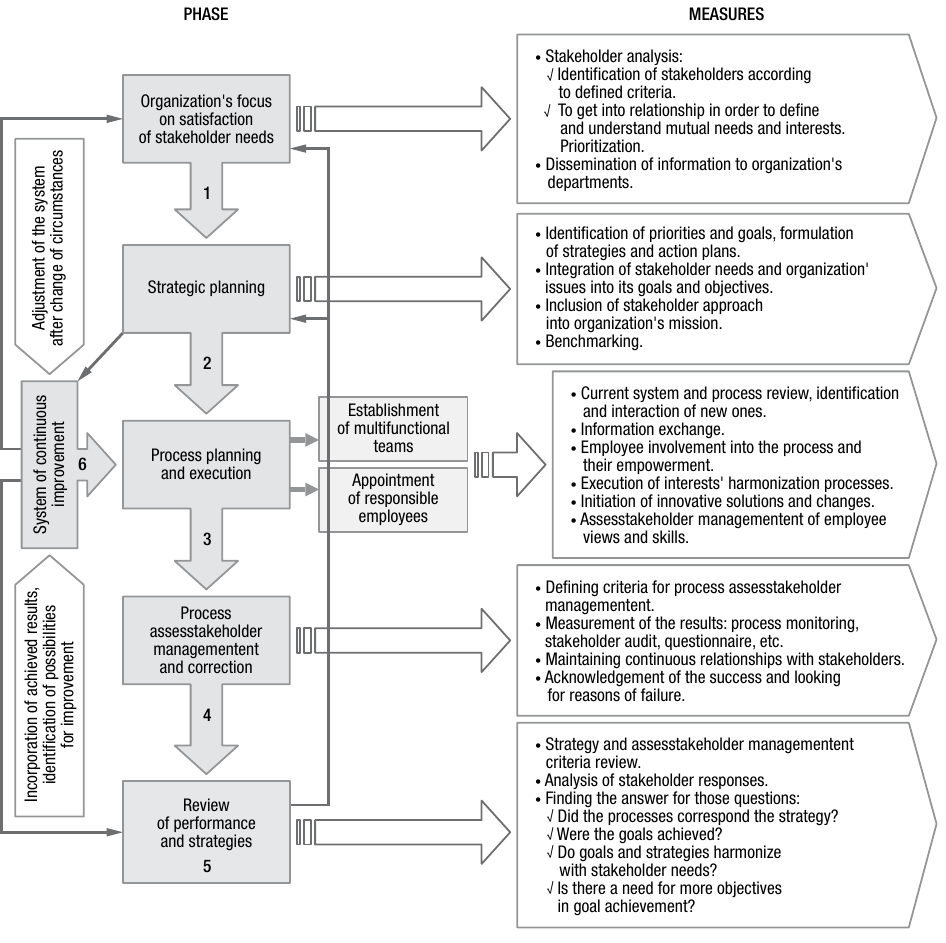
Fig. 1. Stakeholder management